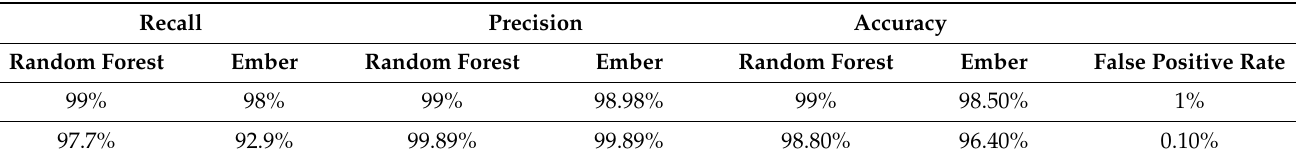
Table 4. Accuracy, precision and recall of the model for different false positive rates (FPRs) in comparison to the baseline model.